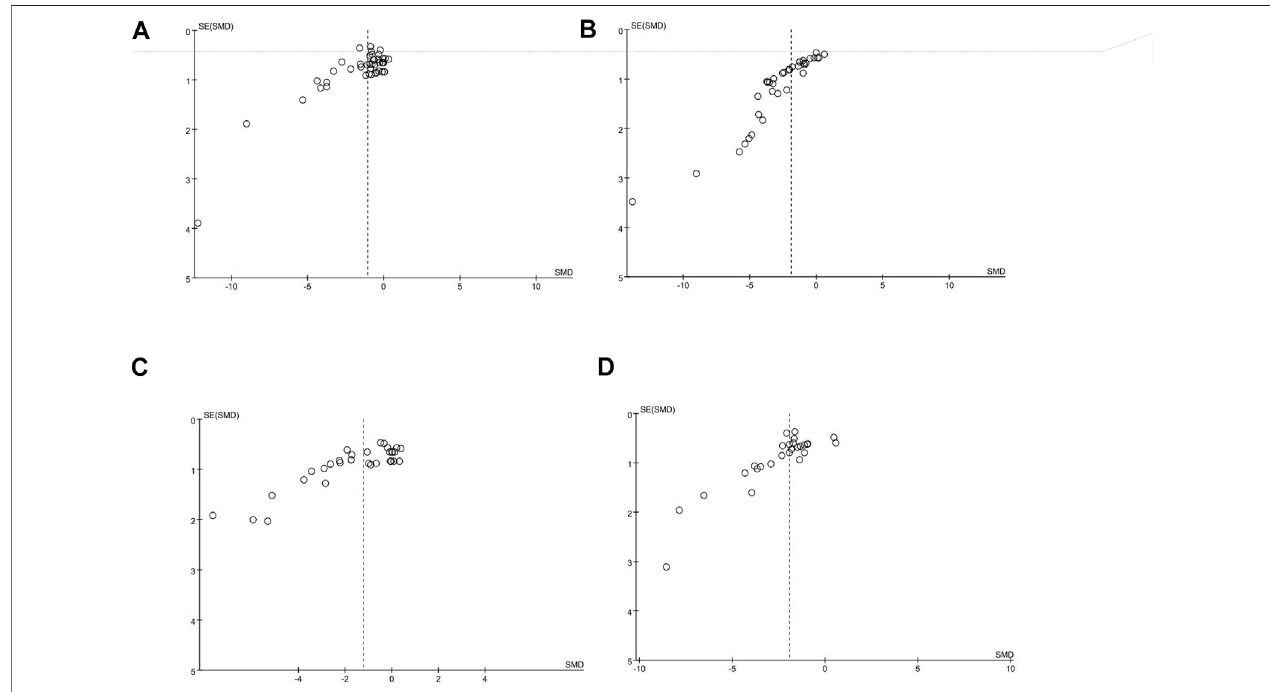
FIGURE 6 | (A) Funnel plot of blood glucose, (B) funnel plot of Scr, (C) funnel plot of BUN, and (D) funnel plot of UP.